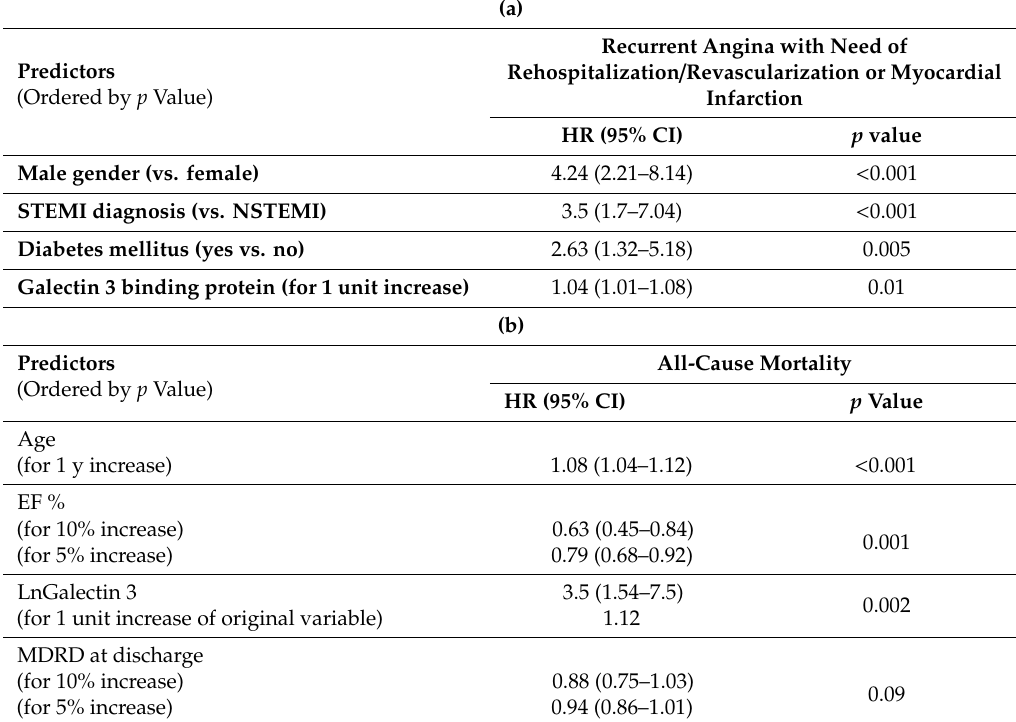
Table 3. (a) Independent predictors of angina / reinfarction at multivariable Cox proportional hazards regression analysis. (b) Independent Predictors of mortality at multivariable Cox proportional hazards regression